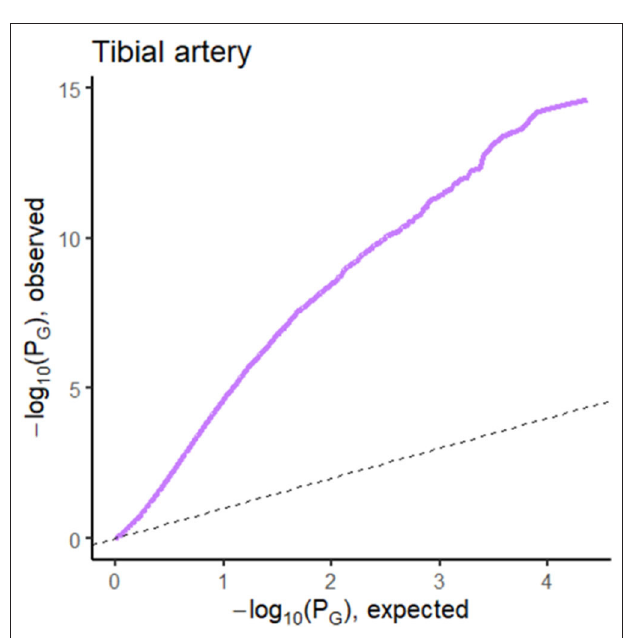
FIGURE 5 | QQ plot of p- values from the regression analysis of pathology phenotype against gene expression for atherosclerosis in tibial artery